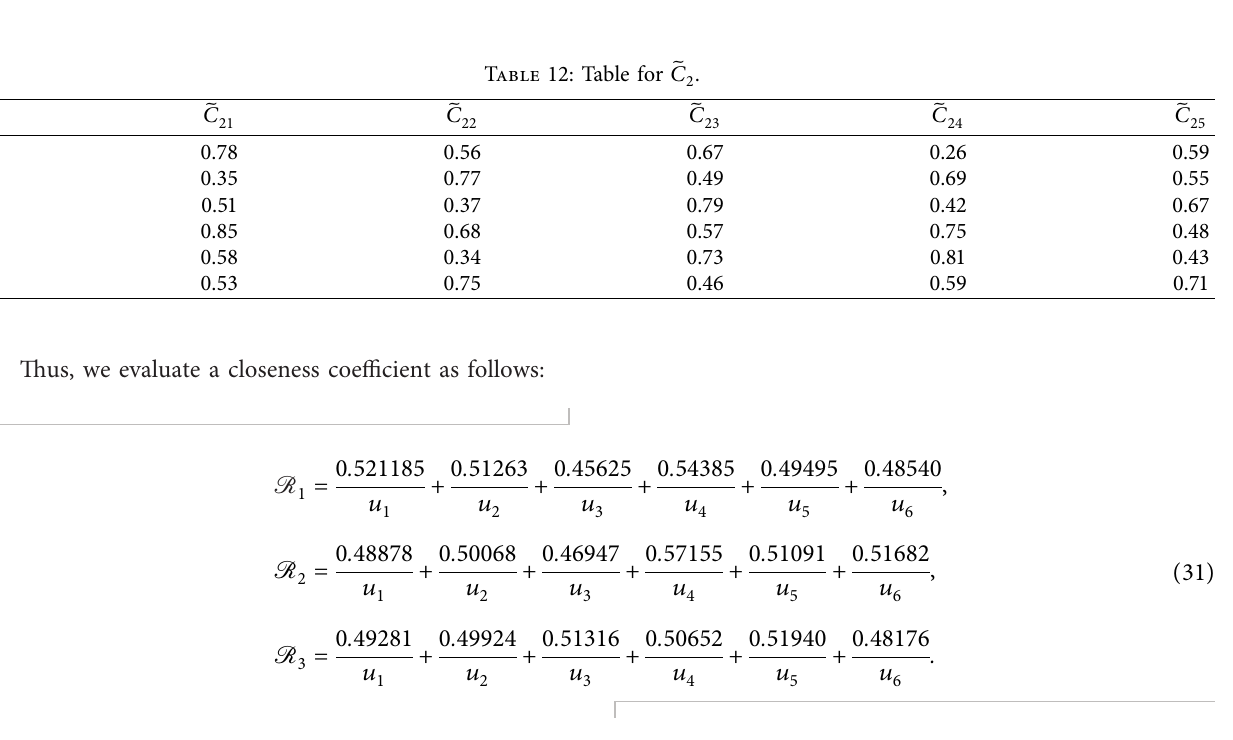
Table 12: Table for 􏽥 C